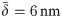
The maximum work per ATP produced by the motor.(A,B) The maximum work per ATP as a function of two dimensionless kinetic parameters for two levels of asymmetry in the force-induced unbinding rates: (A) δ¯=6nm and δa=0.1δ¯ and (B) δ¯=δa=6nm. In each plot, the maximum is marked by a cross. (C) The work per ATP in the optimal kinetic regime as a function of the mean distance parameter δ¯ and its asymmetry distance δa. The dashed line separates different bond types with respect to their behavior under backward load: The area below the dashed line describes a slip bond, the area above the line a catch bond, and the line itself an ideal bond.